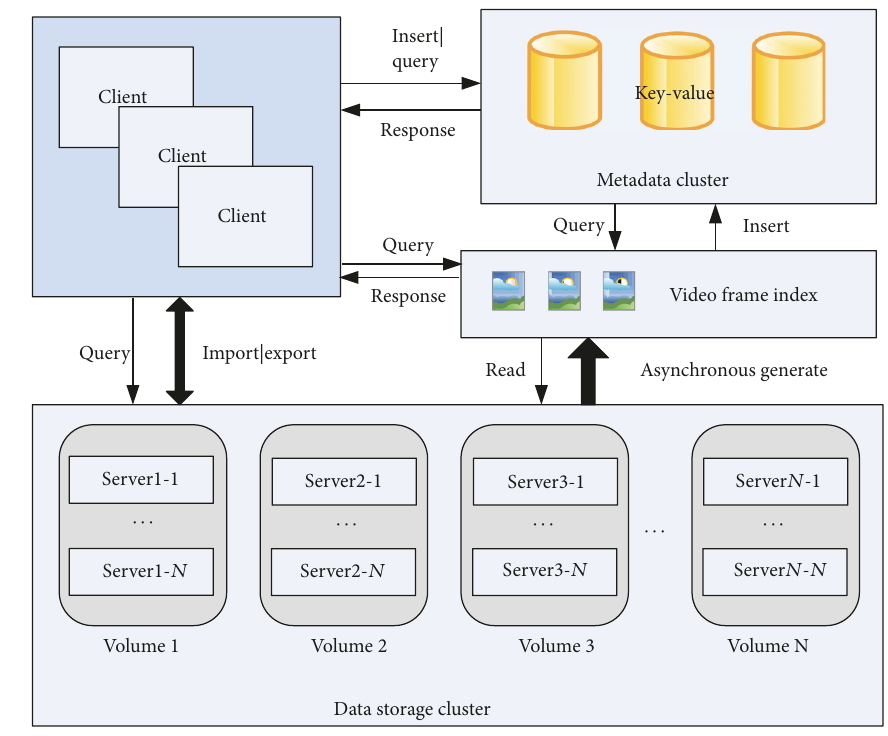
Figure 2: Architecture of CSVS.